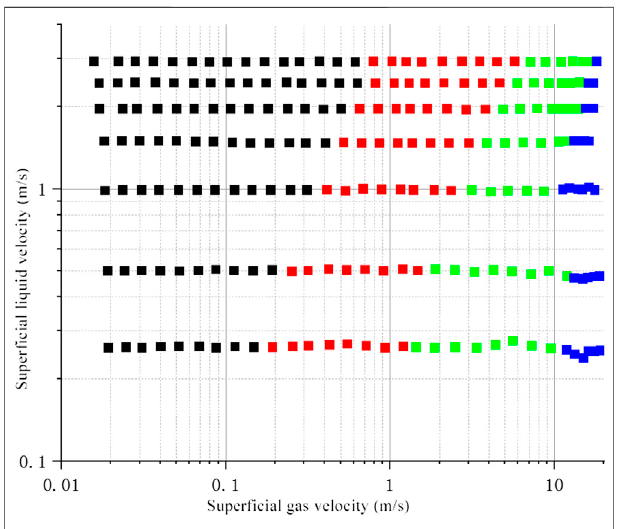
FIGURE 4 | Schematic diagram of experimental conditions.